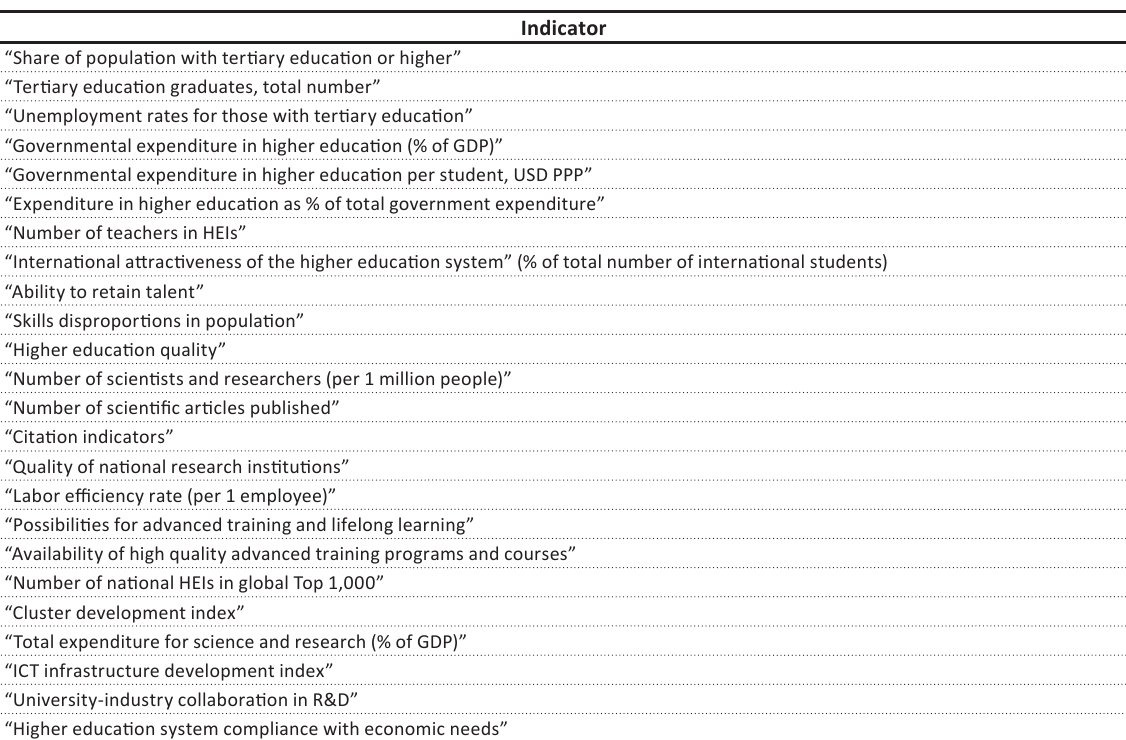
Table B1. Indicators base